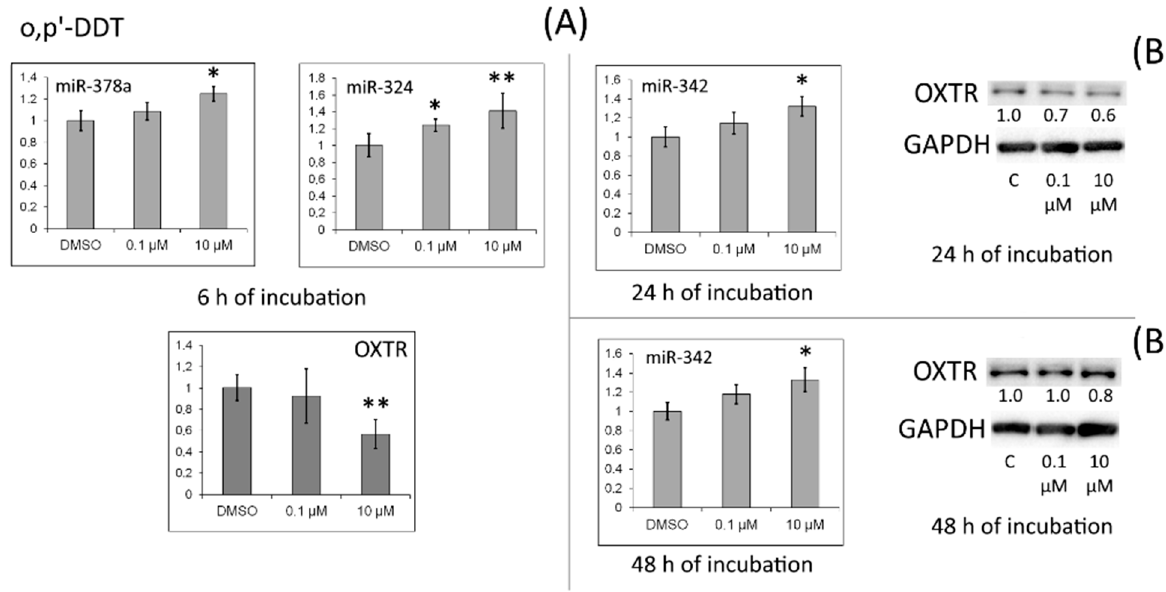
Figure 4. ( A ) Relative levels of OXTR mRNA and of miRNAs targeting it (miR-378a, miR-324, and miR-342) in MCF-7 cells exposed to o,p ′ -DDT. The Y-axis shows the ratio of the mRNA or miRNA amount in the cells treated with a DDT isomer to the mRNA or miRNA amount in the cells treated with DMSO. Each value is the mean of three independent experiments. * Significant differences from the control ( p < 0.05); ** p < 0.01. ( B ) Western blot analysis of OXTR in cells incubated with o,p ′ -DDT. The numbers under OXTR bands represent fold change in the protein level as compared to the first band (control); each data point was normalized to the corresponding GAPDH band. We present findings from one of three independent experiments (which yielded similar